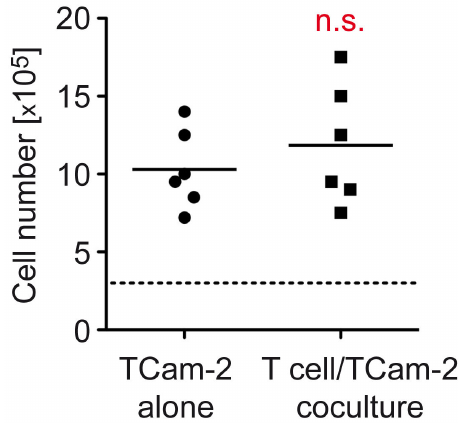
Figure 8. Analysis of TCam ‐ 2 cell growth in T cell cocultures. T cells isolated from PBMC of healthy blood donors by magnetic cell sorting were cultured in 6 ‐ well plates on a monolayer of TCam ‐ 2 cells for 48 h. TCam ‐ 2 cells cultured alone served as a control. TCam ‐ 2 cells were collected after removal of T cells and counted using a Neubauer chamber. N = 6; PBMC were obtained from 2 healthy vol ‐ unteers. The dashed line represents the number of cells before culture. Statistical analysis was performed by unpaired t ‐ test (n.s.: p > 0.05).